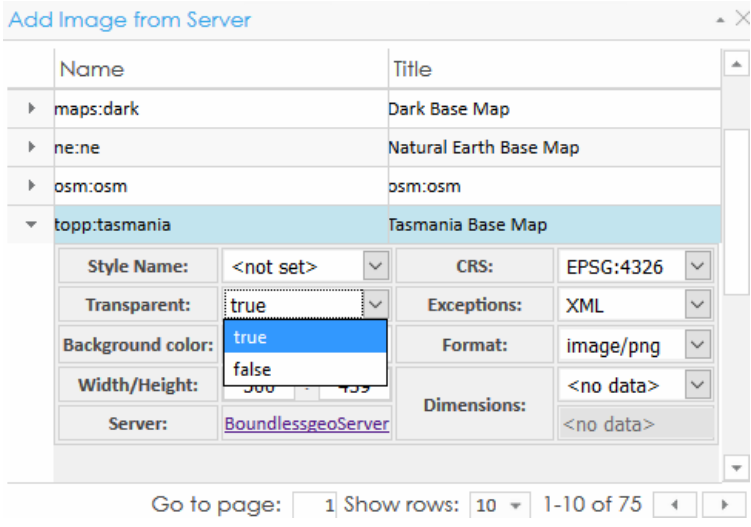
Figure 4. Setting WMS parameters through a paged table.